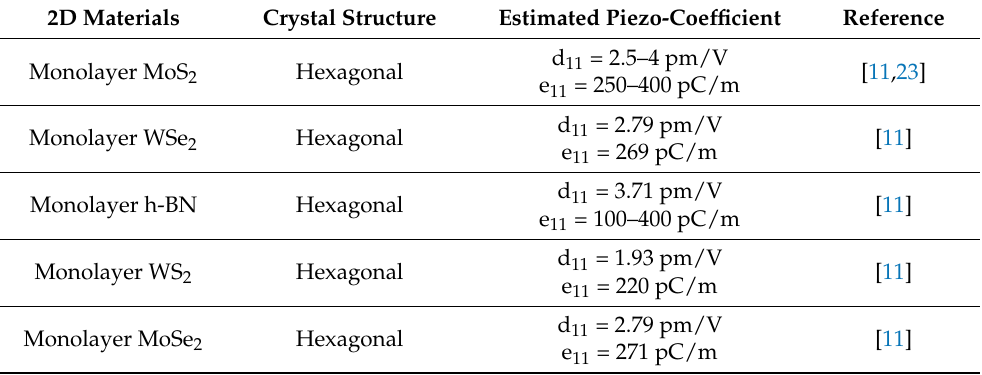
Table 1. Summary of the estimated piezo-coefficient 2D